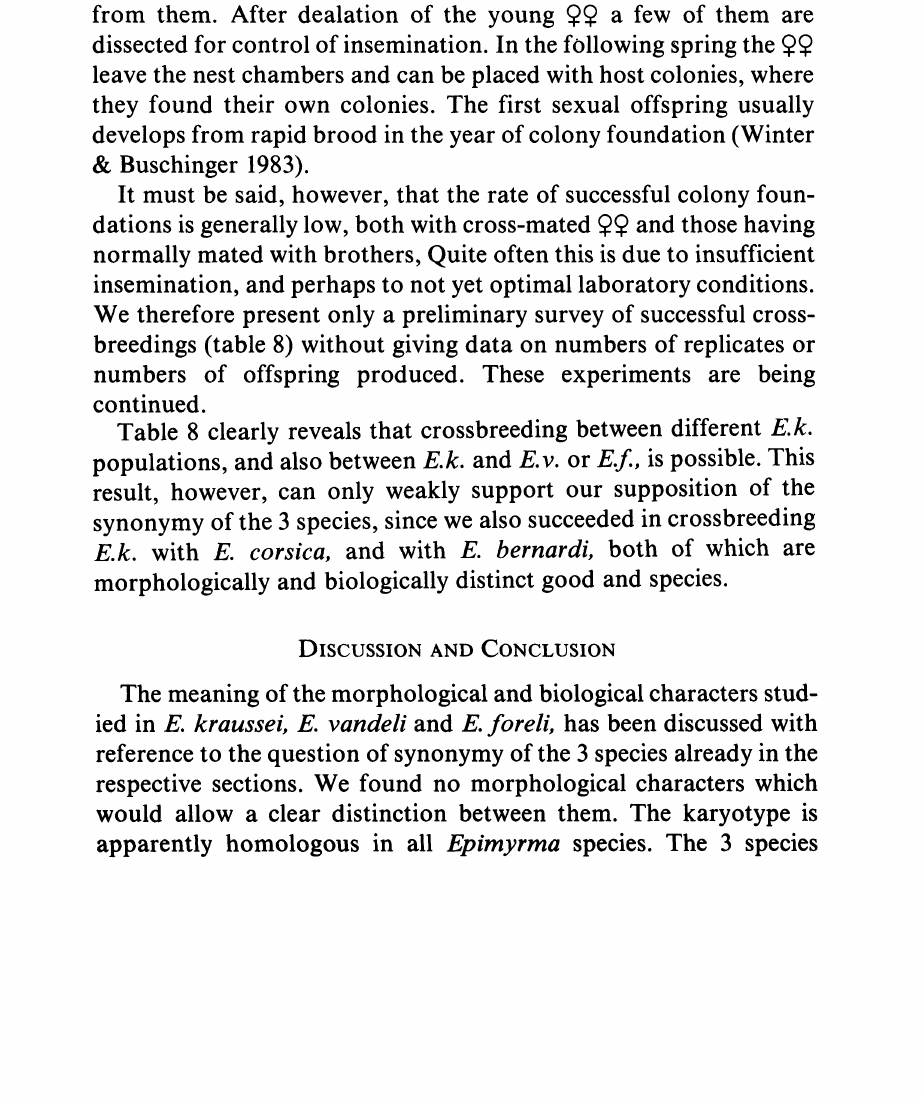
Table 7. Worker-production in colonies of Epimyrma kraussei Emery 1915 from 3 populations, in the first summer after collecting (including the populations of E. foreli Menozzi 1921 and E. vandeli Santschi 1927). Epimyrma produced population n colonies total mean median